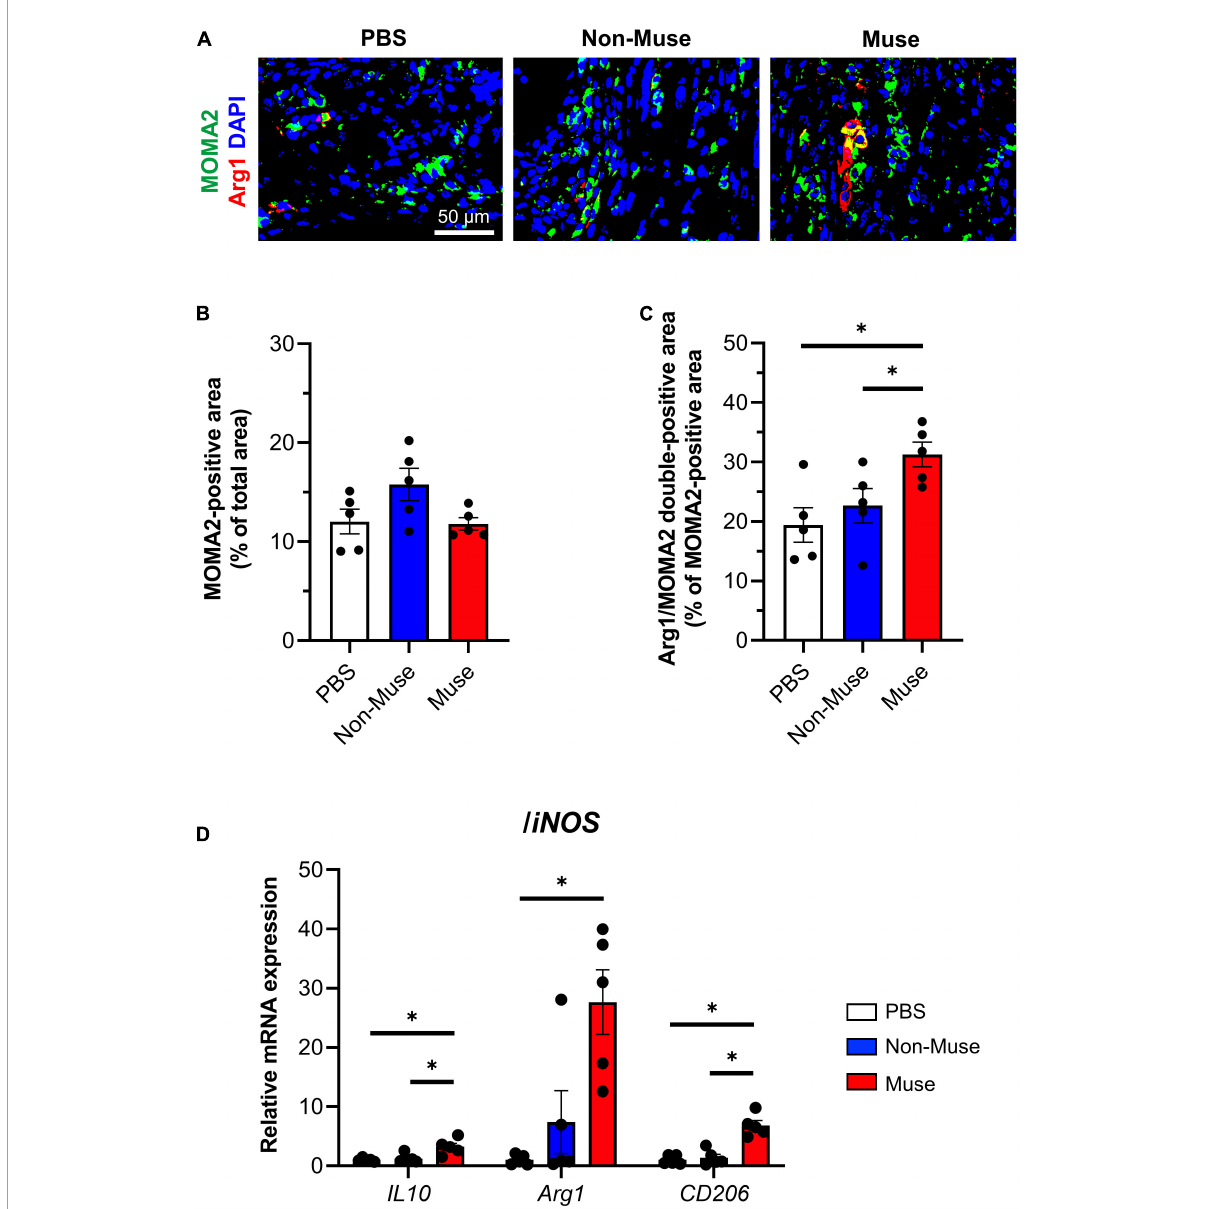
FIGURE4 Muse cells modulated immune responses in ischemic hindlimb. (A) Representative immunofluorescence images of the macrophage/monocyte marker anti-macrophage/monocyte (MOMA2) (green) and the M2 macrophage marker arginase 1 (Arg1) (red) in the ischemic adductor muscle at 5 days after hindlimb ischemia (HLI) surgery. Cell nuclei were stained with 4 (cid:48) 6-diamidino-2-phenylindole (DAPI) (blue). Scale bar, 50 µ m. Muse cells or non-Muse mesenchymal stem cells (MSCs) were intravenously injected 1 day after HLI surgery and phosphate buffered saline (PBS) was injected as a control. (B,C) Quantification of MOMA2-positive area among total section area (B) and Arg1/MOMA2 double-positive area among total MOMA2-positive area (C) . Results are expressed as mean ± SEM ( n = 5). Dots correspond to each biological replicate. (D)